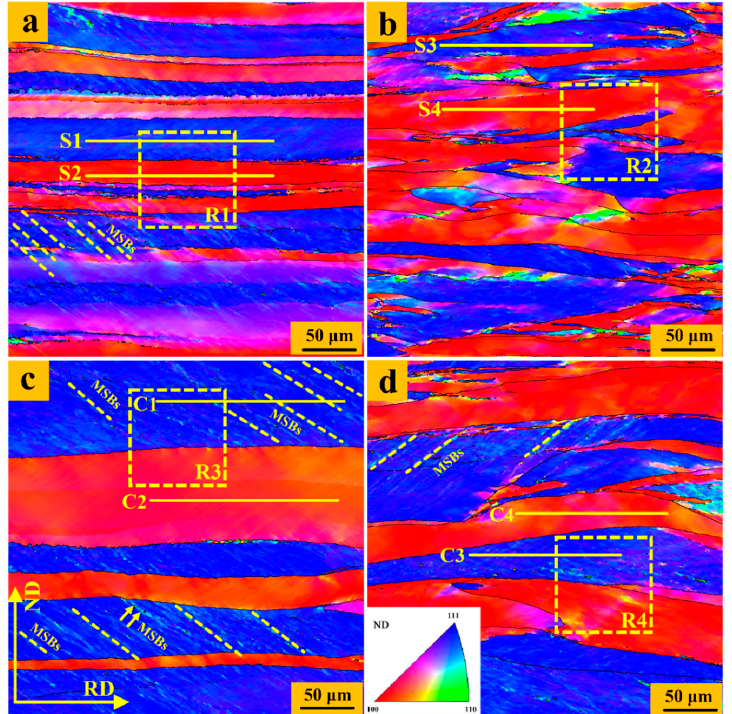
Figure 3. Inverse pole figure (IPF) maps. UR: ( a ) surface region and ( c ) center region, CR: ( b ) surface region and ( d ) center region. Step size 0.25 μ m.